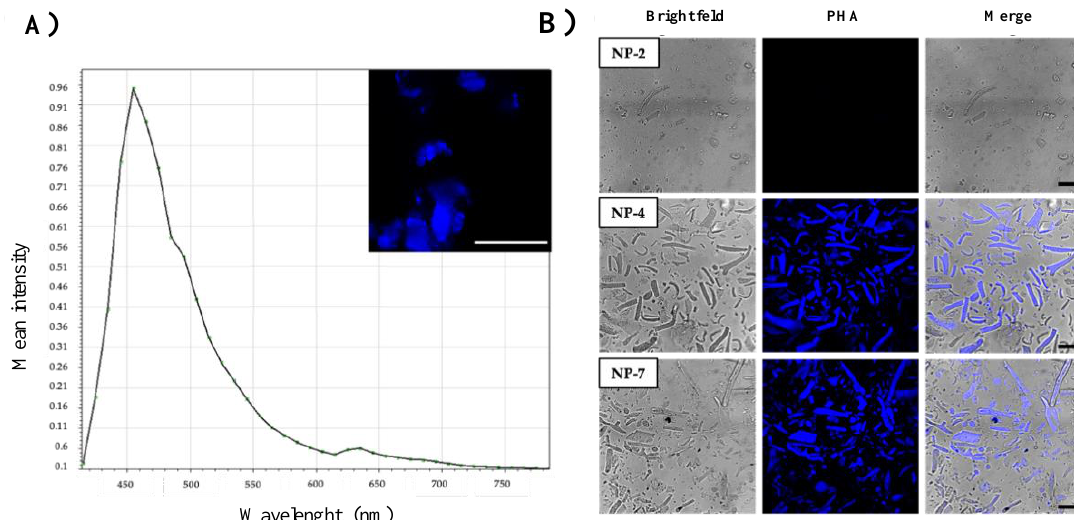
Figure 4. ( A ) Emission spectrum of PHA. ( B ) Representative confocal images of blank nanoparticles (NP-2) and PHA-loaded NPs (NP-4 and NP-7). Scale bars: 20 µm.